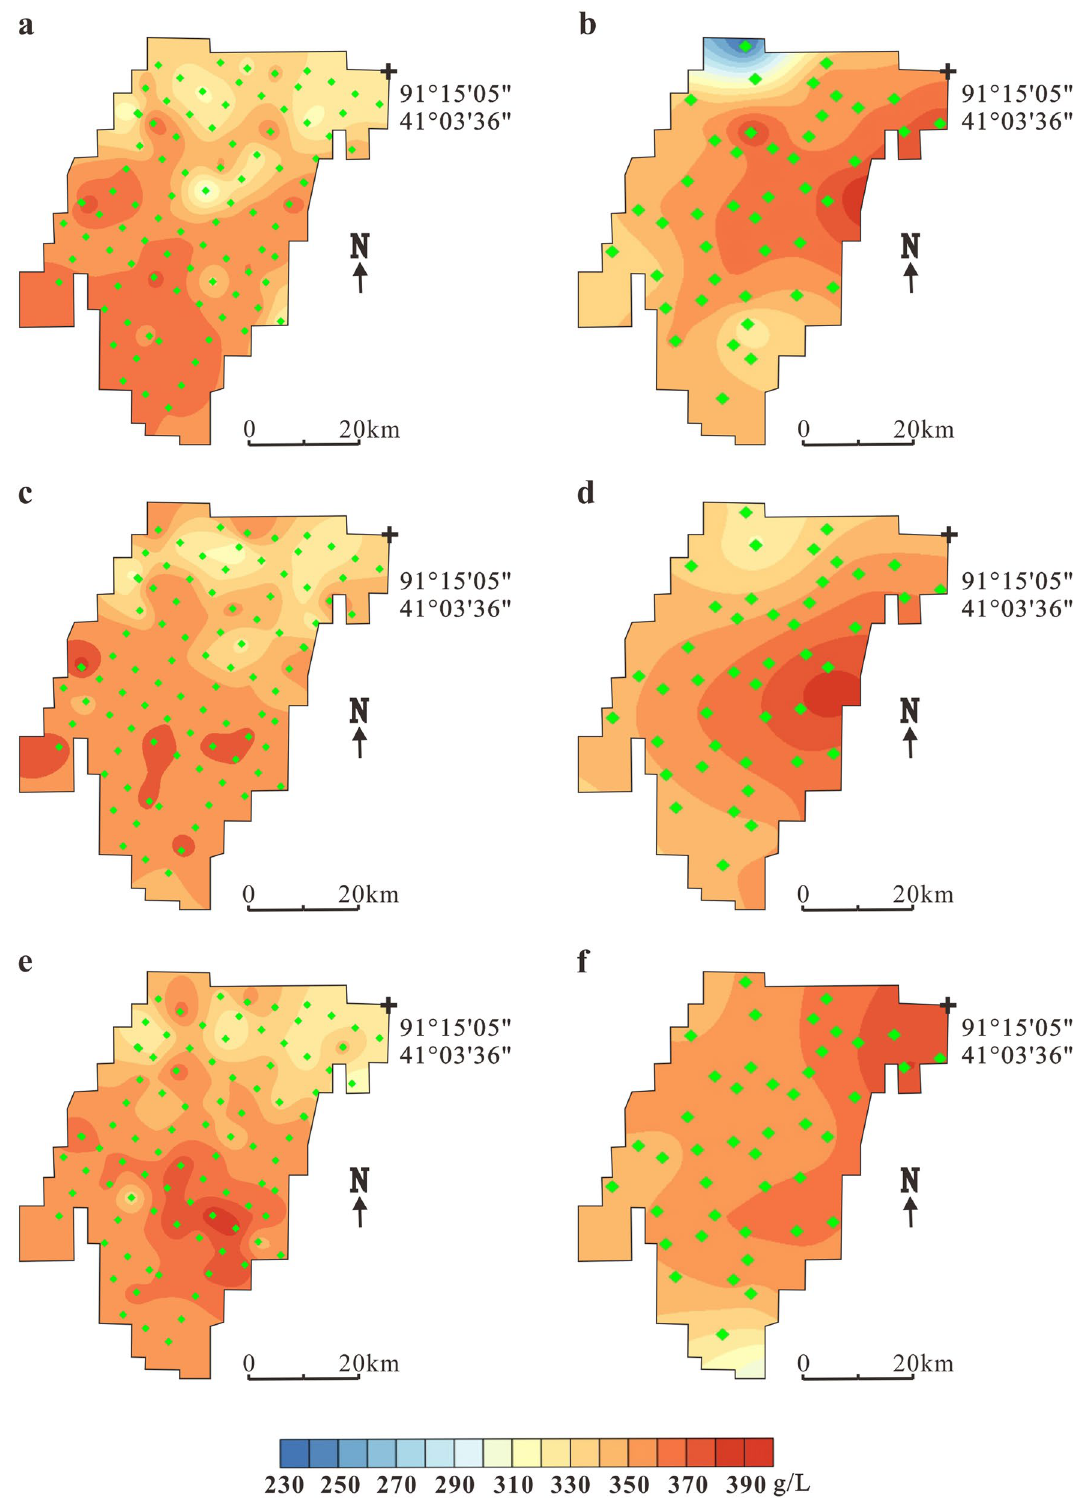
Figure 3. Temporal and spatial variations in the salinity of different brine layers in Luobei depression. ( a ) Layer W 1 in 2006, ( b ) Layer W 1 in 2017, ( c ) Layer W 2 in 2006, ( d ) Layer W 2 in 2017, ( e ) Layer W 3 in 2006 and ( f ) Layer W 3 in 2017. The green dots indicate observation holes